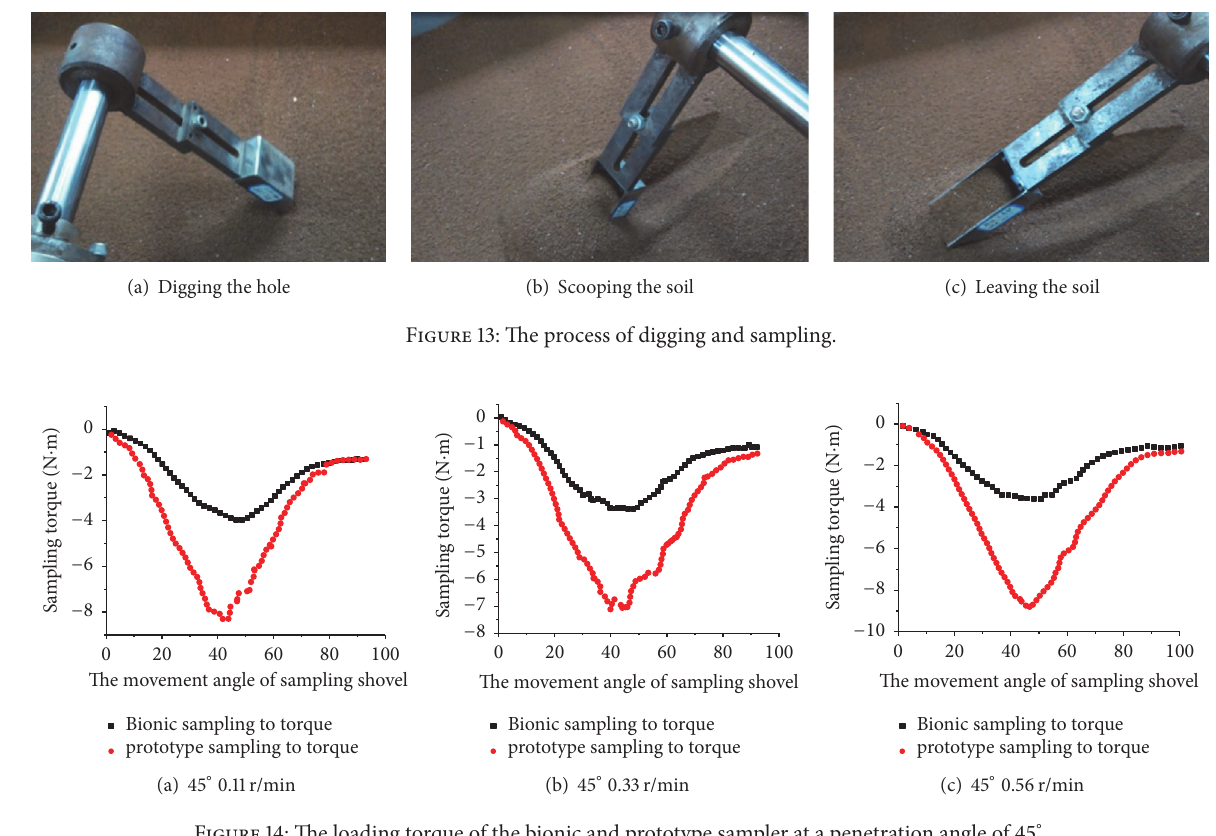
habits, we concluded that the second clawed toe of the front foot was the most important for